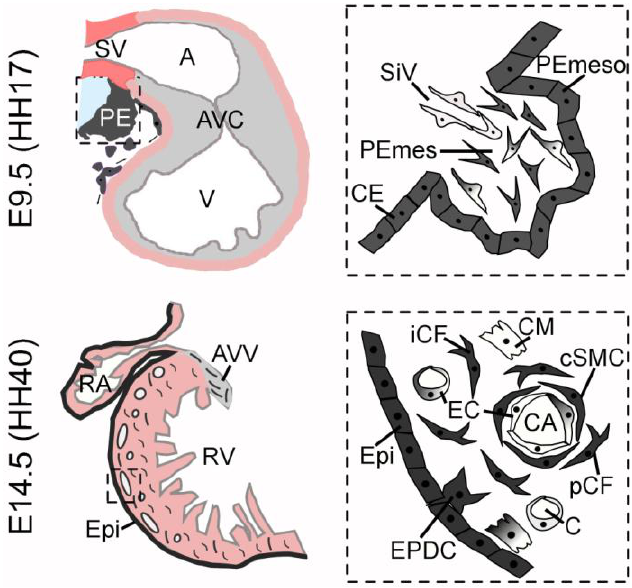
Figure 1. Scheme of (pro-)epicardial lineages. The upper row shows a schematic view of an E9.5 sagittally sectioned murine heart (similar to HH17 avian heart) on the left side. The proepicardium (PE) is indicated in dark grey, the chamber myocardium in light pink, the sinus venosus mesenchyme (SV) in red and the cardiac jelly and cushion mesenchyme in light grey. Note the close proximity of proepicardium, sinus venosus mesenchyme, septum transversum and liver, respectively (light blue). The right scheme represents a magnification of the proepicardium (boxed area). Coelomic epithelium (CE) and the proepicardial mesothelium (PEmeso) are indicated in dark grey and share the expression of Tbx18 and Wt1 . Proepicardial mesenchymal cells (PEmes) are highly diverse. Wt1 -, Tbx18 , Scx -, Sema3D - and Tcf21 -expressing cells are found within the mesenchyme with varying overlapping expression patterns. Their individual descent and contribution to the heart have remained largely elusive. Sinusoid-like vessels (SiV) reach into the proepicardium and may provide endothelial cells. The lower row shows a scheme of the murine heart at E14.5 (resembling an avian heart at HH40). Epicardium-derived cells (EPDCs) are indicated in dark grey and invade the ventricular myocardium as well as the cushion tissue of the atrio-ventricular valves (AVV). A higher magnification of the boxed area within the right ventricle (RV) is given to indicate the fate of these cells. They mainly contribute to coronary smooth muscle cells (cSMC) and interstitial (iCF) as well as perivascular fibroblasts (pCF). An epicardial origin of endothelial cells (EC) and cardiomyocytes (CM) is unlikely (indicated by a gray-white gradient within these